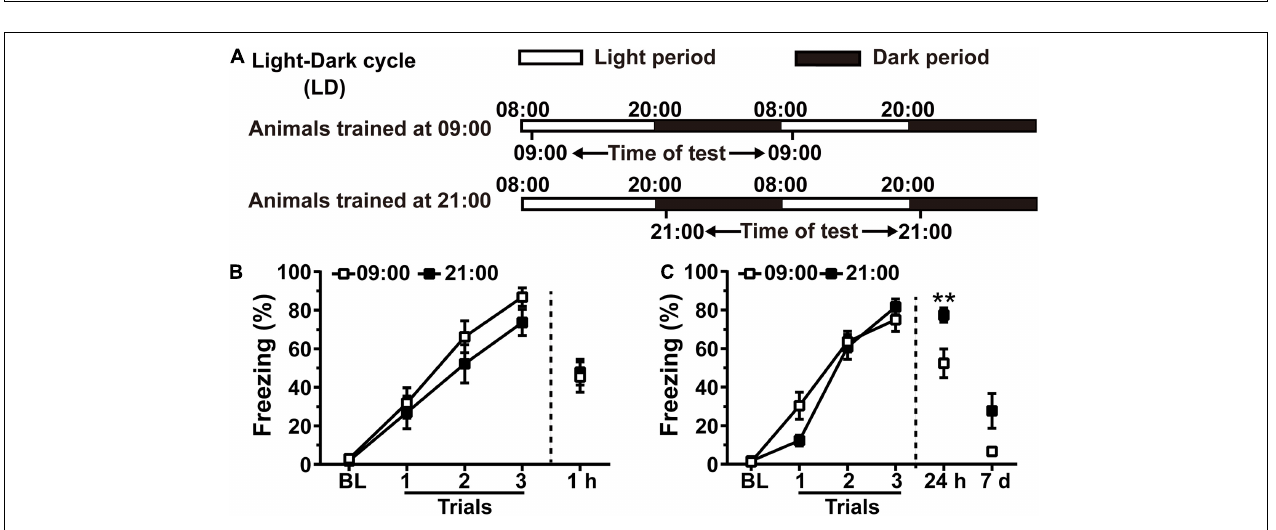
FIGURE 2 | Training at the lower hippocampal Rac1 activation period during the night leads to better contextual fear memory in rats. (A) Diagrams for experimental procedures. (B) The contextual fear memory was not different between the 09:00 group and 21:00 group when tested at 1 h after learning. (C) The contextual fear memory was better in the 21:00 group at 24 h and 7 days after learning. Data are presented as mean ± SEM. ** p <